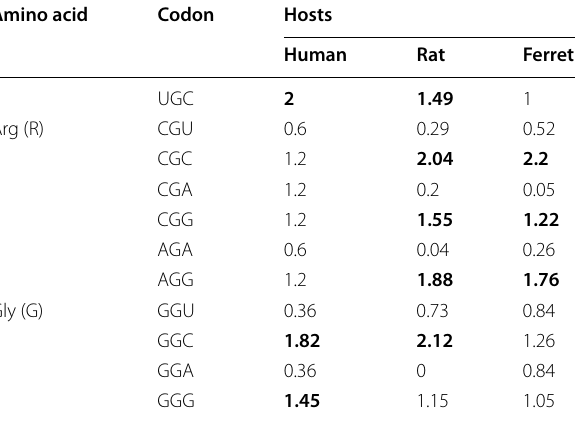
(Table 2). This indicated preference of C- and G-ended